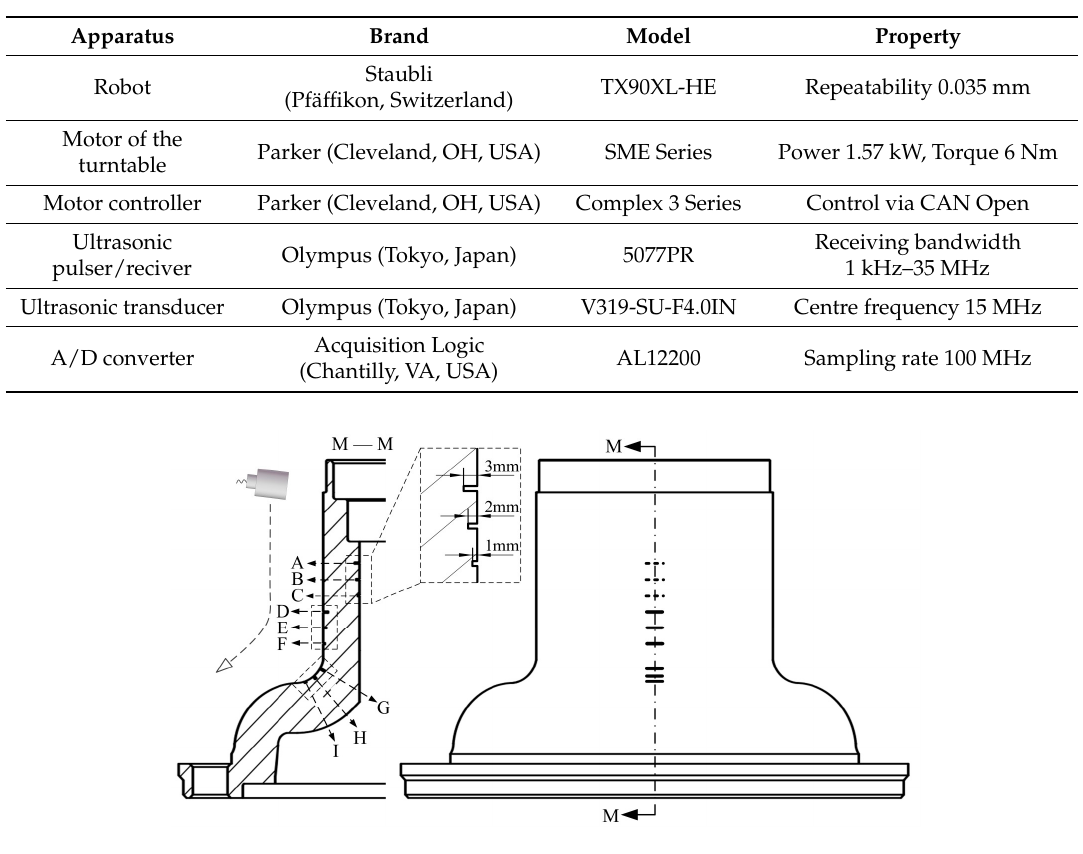
Figure 6. The distribution of transverse cracks.